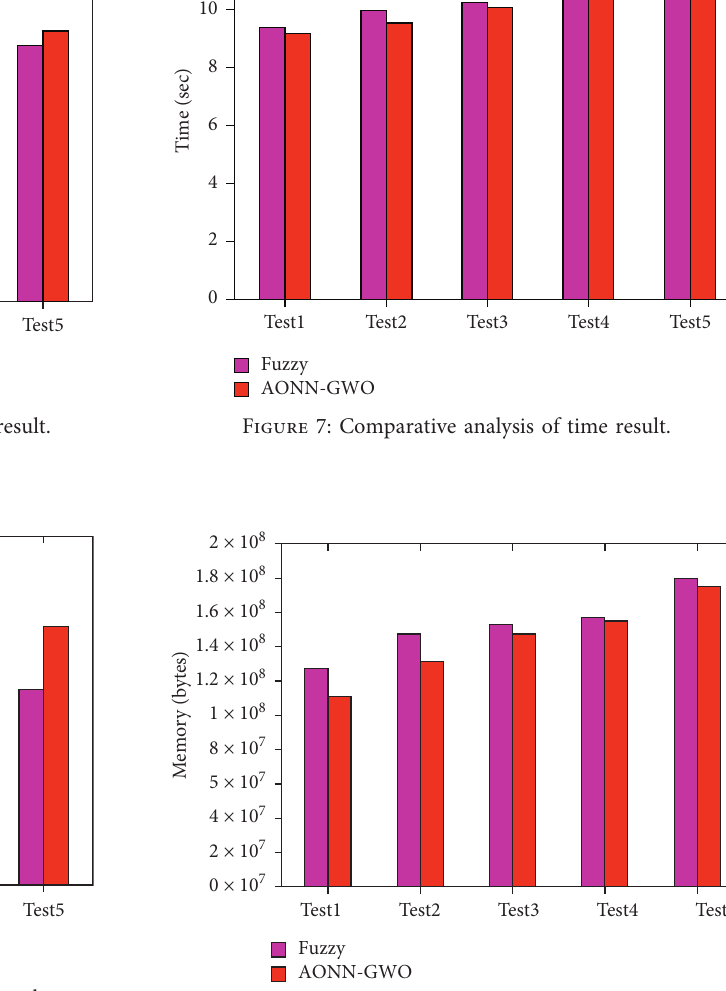
Figure 8: Comparative analysis of time result.